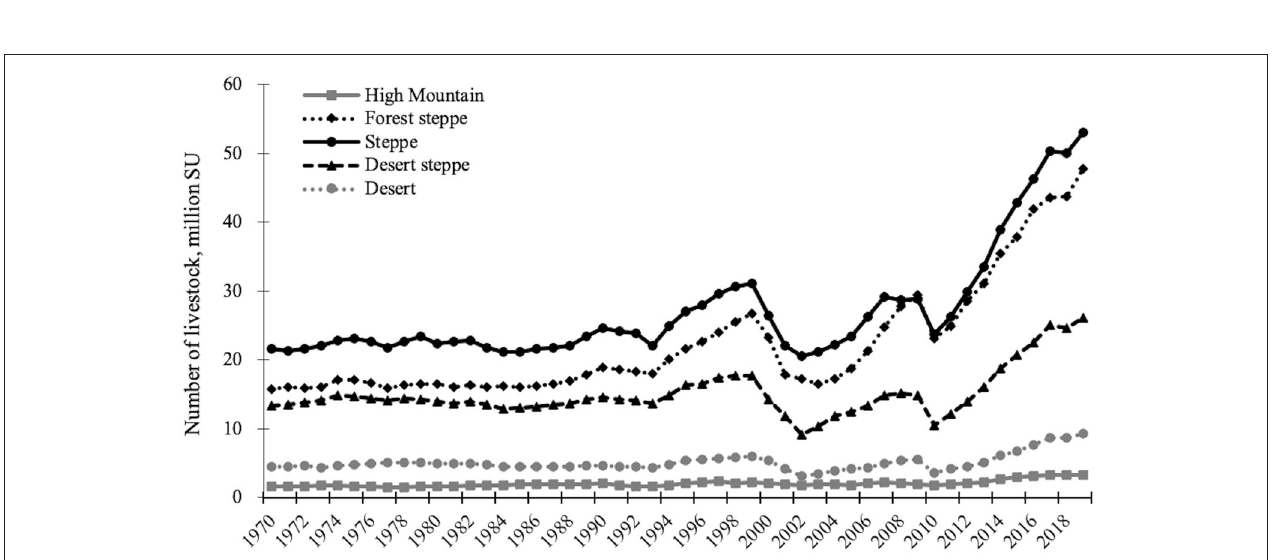
FIGURE 2 | Change in livestock numbers in different ecological zones of Mongolia. The total number of livestock in a particular zone was calculated from data at the soum (small administrative unit within a province) level (330 soums and 9 districts of the capital city, in total, N = 339). A total of 216 soums had only one dominant ecological zone, so the livestock number in this zone is equal to the soum level. When a soum consists of more than one ecological zone, then each of the two ( N = 111) or three ( N = 12) most dominant zones were considered to have the same number at soum level, because livestock mobility is high even within a single soum. Therefore, there is an overestimation of total livestock numbers (the sum of sheep units from ecological zones are 11–20% higher than those from soums for the respective year range). Data at the soum level were provided by the National Statistics Office of Mongolia, 1970–2019. The Taiga zone is not included because this zone is a boreal forest, where hardly any pasture